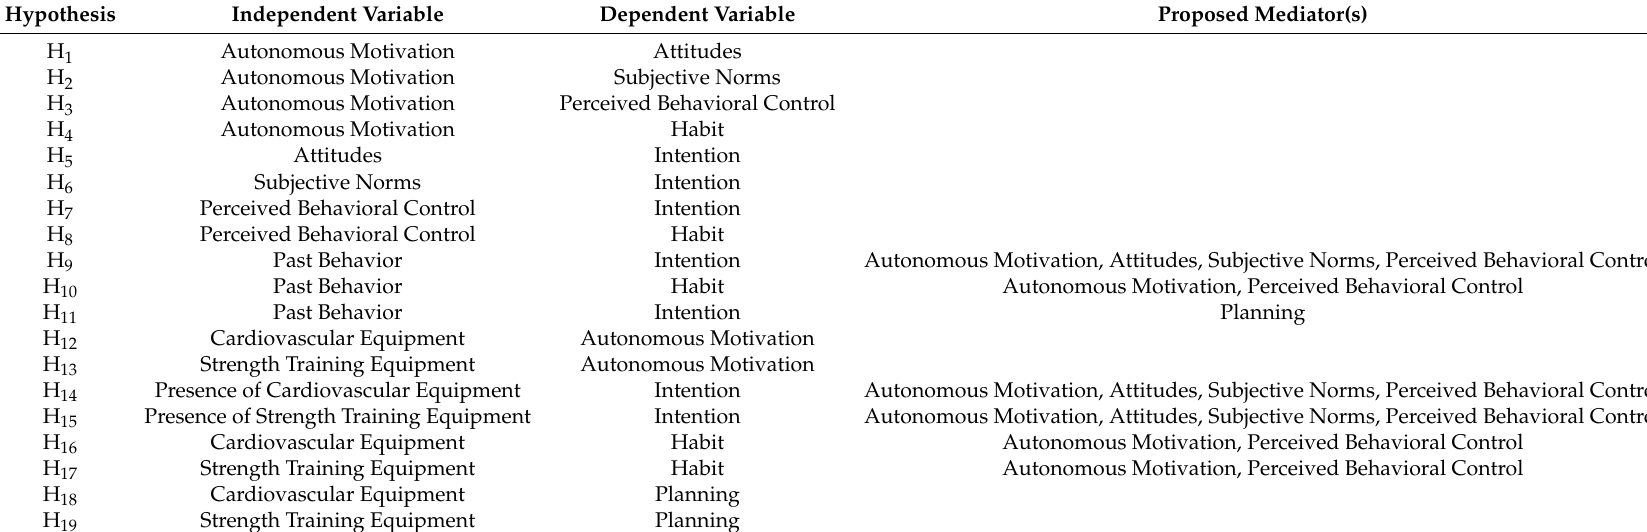
Table 1. Summary of study